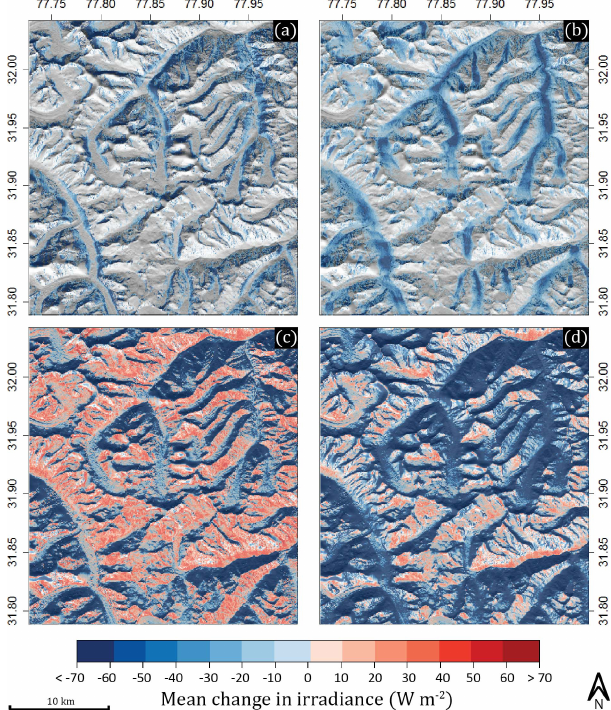
Figure 8. Expanded view of the Satluj basin including surrounding glacial valleys of various orientation and aspect. Mean change in irradiance due to shaded relief (a) , cast shadows (b) , slope and as- pect (c) , and combined topographic components (d) is compared. Cast shadows show to be most influential in north- and south- facing valleys and can even offset the increase in irradiance due to slope and aspect for some south-facing valleys. Changes less than ± 10Wm − 2 are not